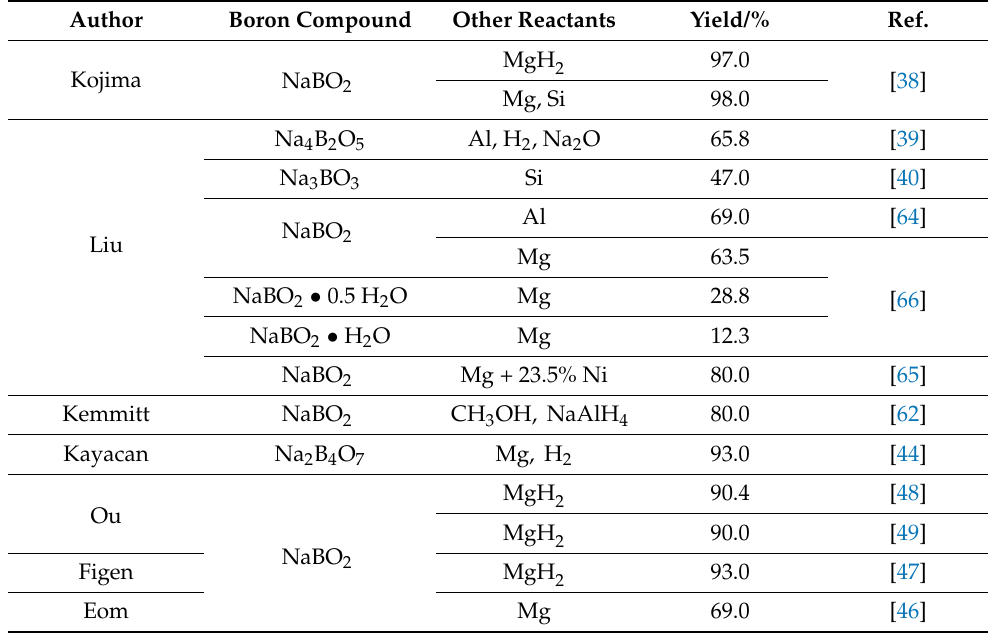
Table 1. Summary of thermochemical processes for NaBH 4